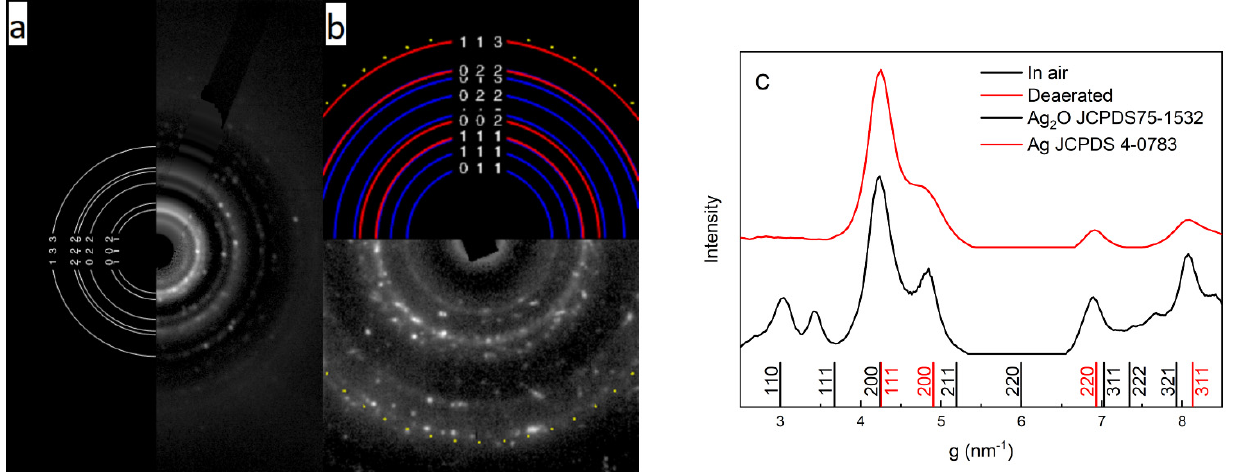
Figure 2. Diffraction pattern of Ag ( a ) and Ag 2 O-Ag ( b ) nanoparticles and comparison of the intensity of electron diffraction reflexes and JCPDS data ( c ), respectively.